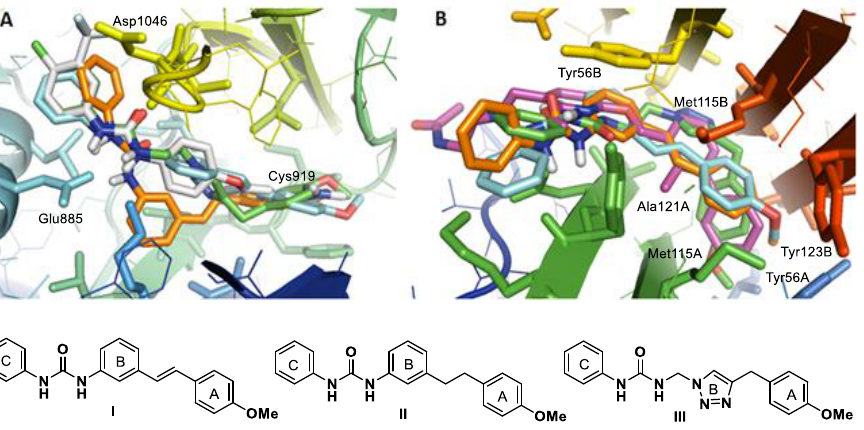
Figure 2. ( A ) Superposition of Compounds I (orange), II (light blue), III (green) and sorafenib (gray) in the kinase domain of VEGFR-2. ( B ). Superposition of Compounds I (orange), II (light blue), III (green) and BMS-202 (violet) at the PD-L1 binding site.